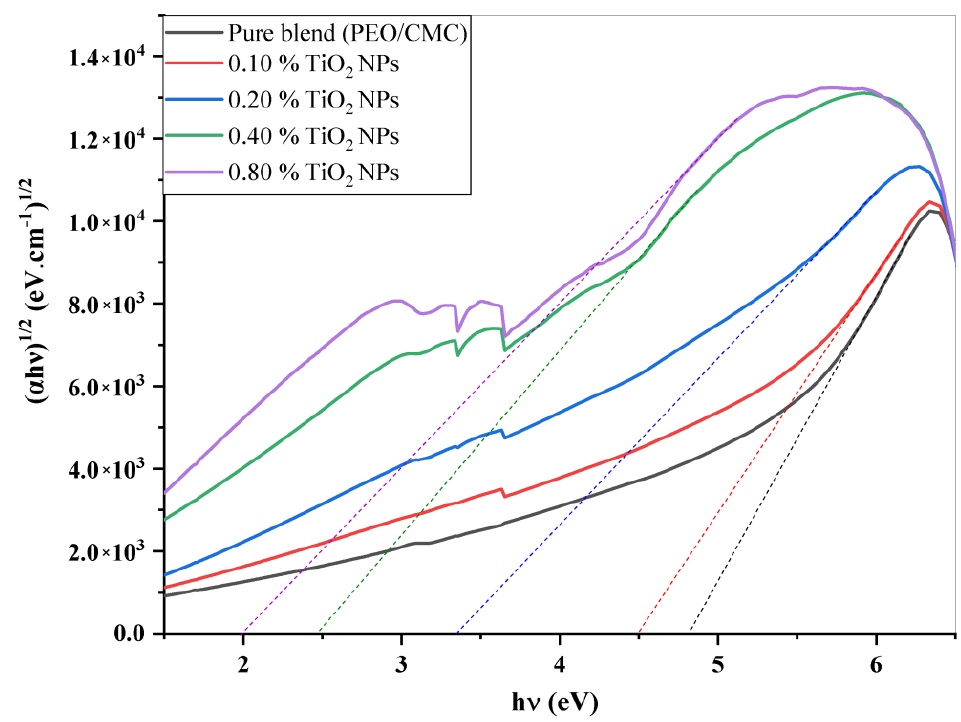
Figure 6. Plots of (α hυ ) 1/2 vs. hυ of PEO/CMC and PEO/CMC filled with various amounts of TiO 2 NPs